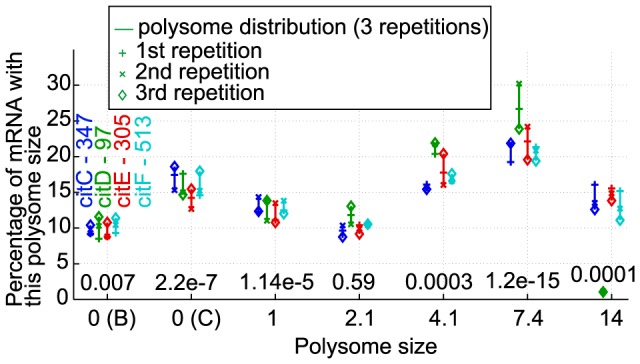
Polysome sizes of genes from experimentally verified operon citCDEFXG.One color was associated to each gene part of this operon (gene is absent of the figure when its experimental polysome size was missing). For each operonic gene, its mRNA proportions (from three repetitions) were plotted according to polysome size. Results from other operons are shown in Figure S5. The gene names and lengths (in number of codons) are indicated in the first fraction. The number above each polysome size is the p-value of the ANOVA test to check at a given polysome size if the mRNA proportion of the group of operonic gene is significantly different than the mRNA proportion of the rest of the genes in this fraction. For example in this figure, gene citC has a length of 347 codons, and about 10% of its mRNA copies are in fraction B, 17% in fraction C, … and 15% of its copies have a polysome size around 14; moreover, an ANOVA test shows with a p-value of 0.0001 that, in fraction of polysome size 14, the average mRNA proportion from the cit operon's genes is significantly different to the average mRNA proportion from the other gene species in this fraction (and similarly for the other elution fractions), hinting that the genes from cit operon are not distributed among fractions in the same way as the rest of the genes.